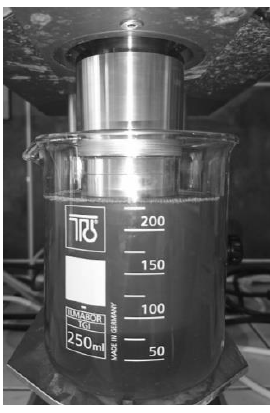
Figure 4. Removal of a mud cake from the rotor surface.